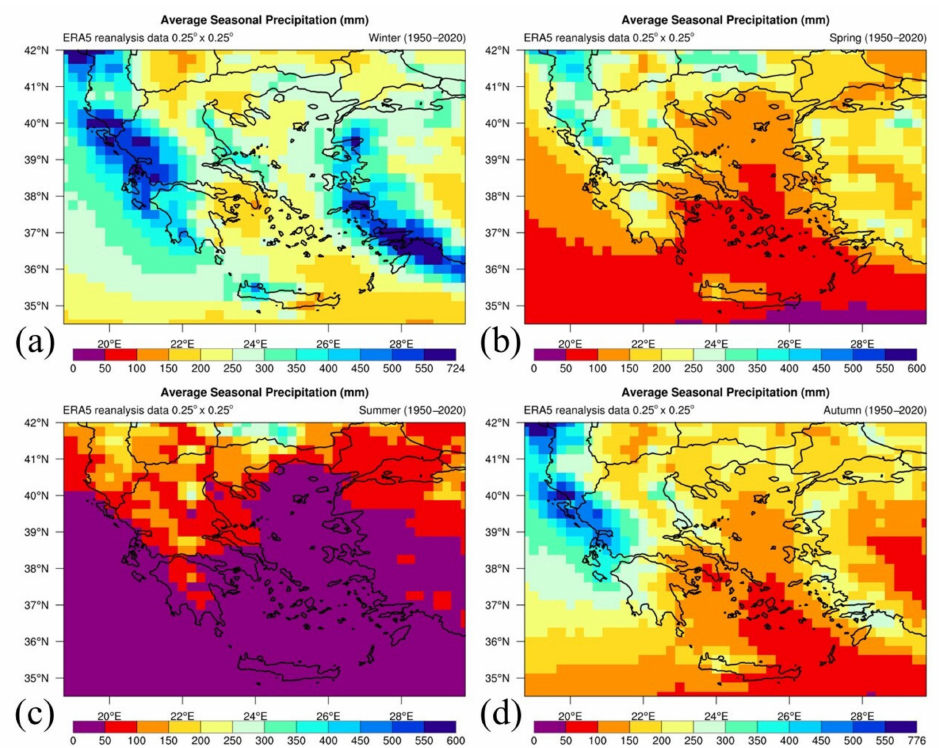
Figure 4. Spatial distribution of average precipitation (mm) for ( a ) winter (December, January, and February; DJF); ( b ) spring (March, April, and May; MAM); ( c ) summer (June, July and August; JJA); and ( d ) autumn (September, October and November; SON) for the period